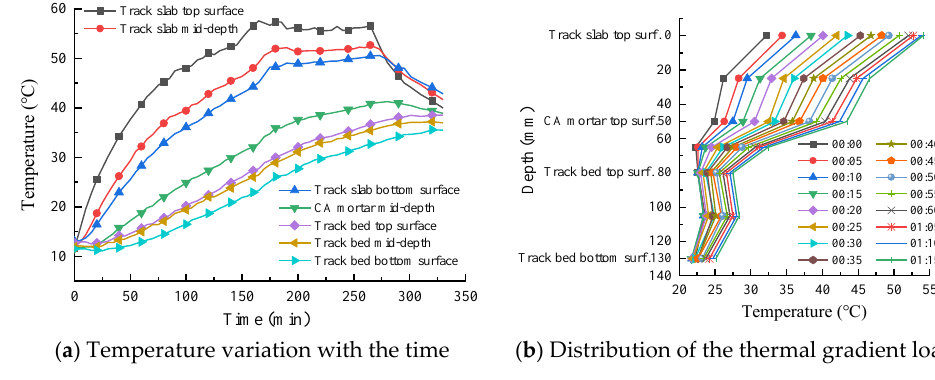
Figure 8. Thermal load of the track structure.